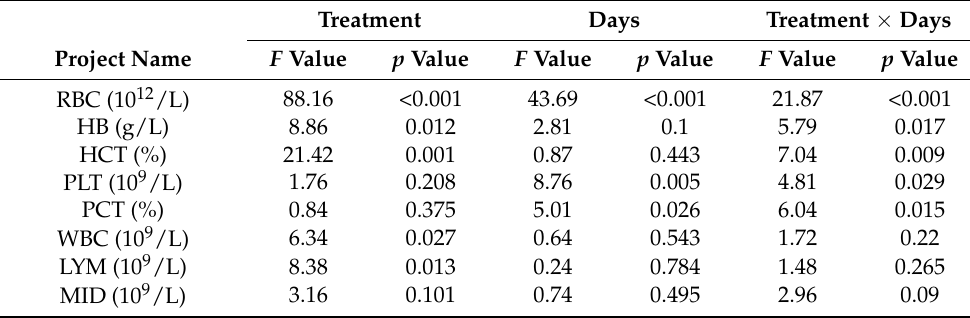
Table 5. Effect of broiler AS on blood routine parameters.